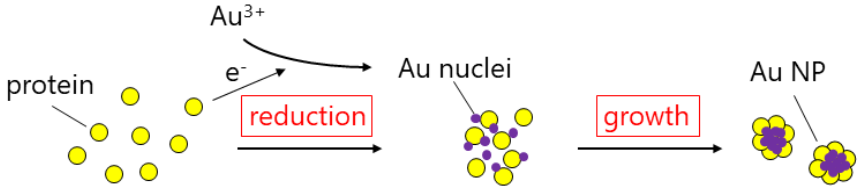
Figure 6. The mechanism of Au NPs synthesis by L . casei . Au ion was reduced by diglycosyldiacylglycerol (DGDG) (glycolipid in cell membrane) and lacto- N -triose. Au crystals were kept small by lactic acid secreted from the cell.